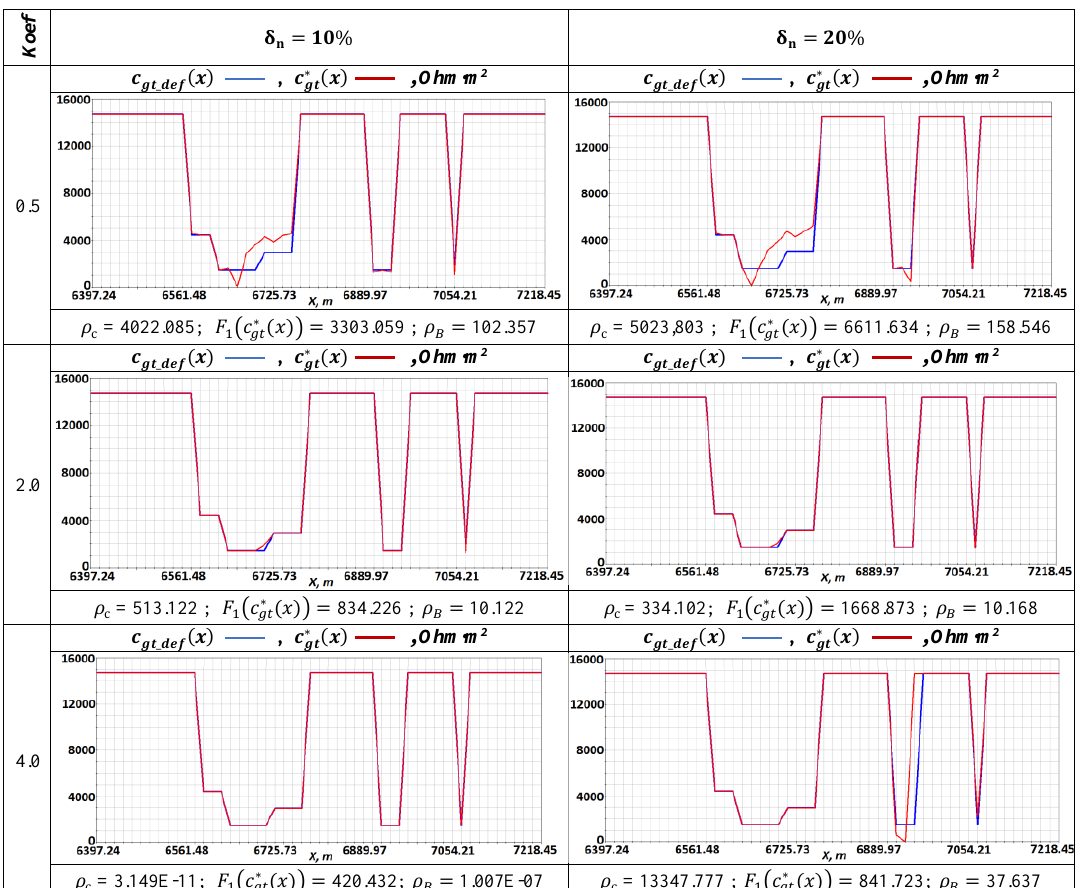
(𝒙) ) and obtained ( 𝒄 𝒈𝒕∗ (𝒙) ), as a solution of an inverse Figure 4. Comparison of the given ( 𝒄 𝒈𝒕_𝒅𝒆𝒇 problem IP , functions of transition resistance at the boundary of